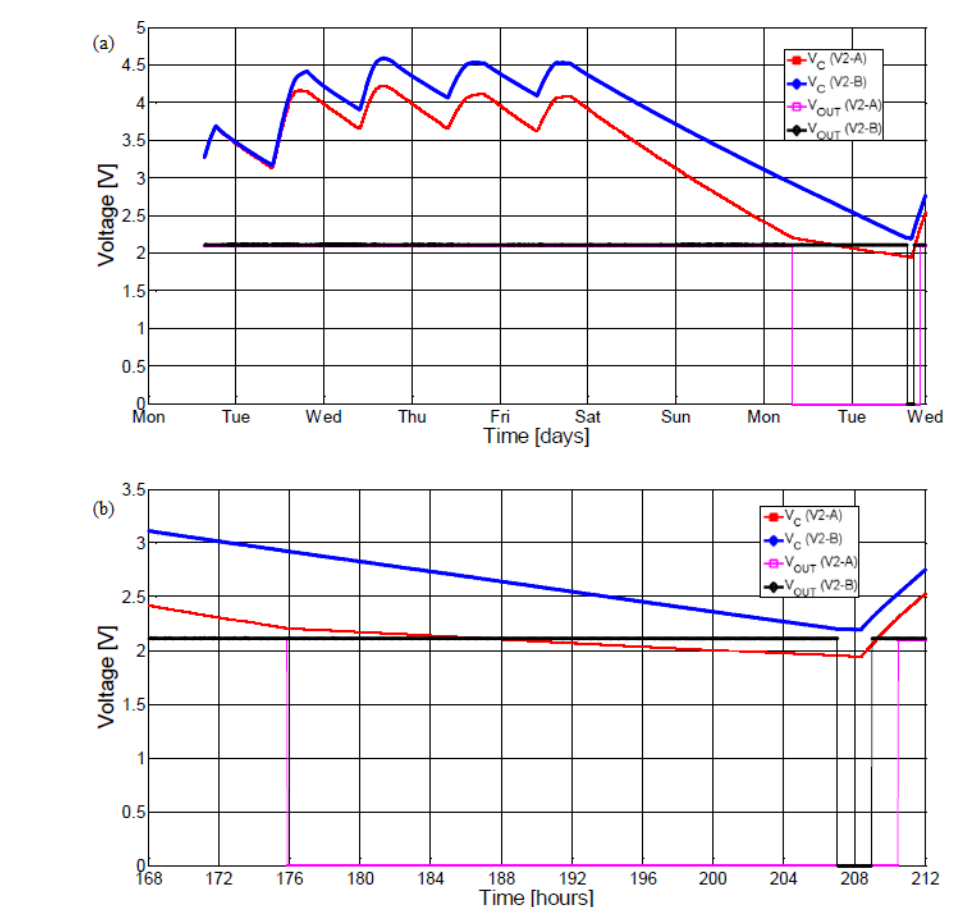
Figure 3. (a) Evolution of the voltage at the supercapacitor ( V C ) subjected to charging from 8h light during 5 days followed by a full dark period until insufficient voltage to operate. The cold start is observed after being lighted again. (b) Zoom on the last hours of the measurements when not enough energy is available to get V OUT = 2.1V at the voltage regulator output. V2-A and V2-B refer to the standard PMU and enhanced PMU, respectively.